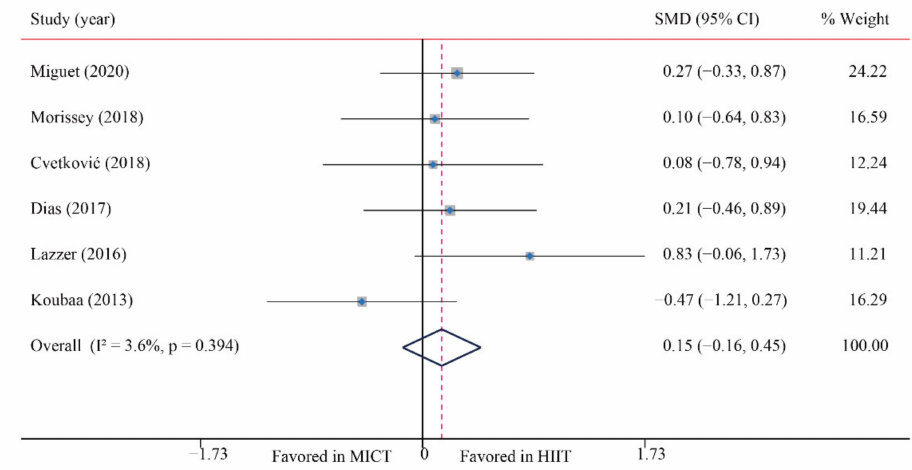
Figure 5. Effect of HIIT versus MICT on fat free